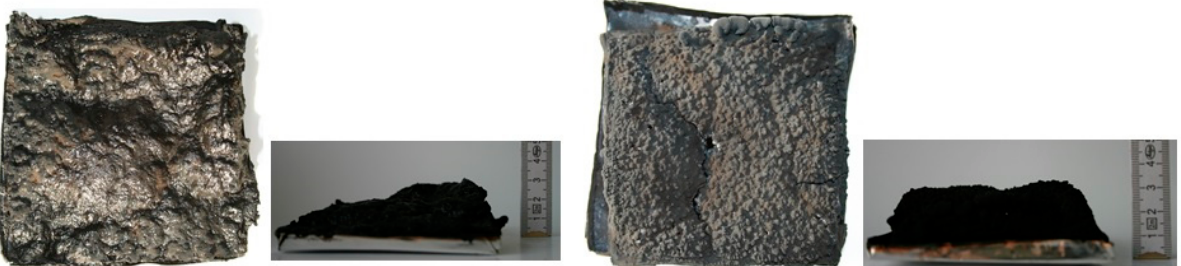
Figure 8. Photographs of the UP/30APP and UP/30LHP after cone calorimetry tests.